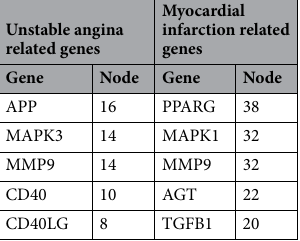
Table 2. Top five hub genes identified from the PPI networks.